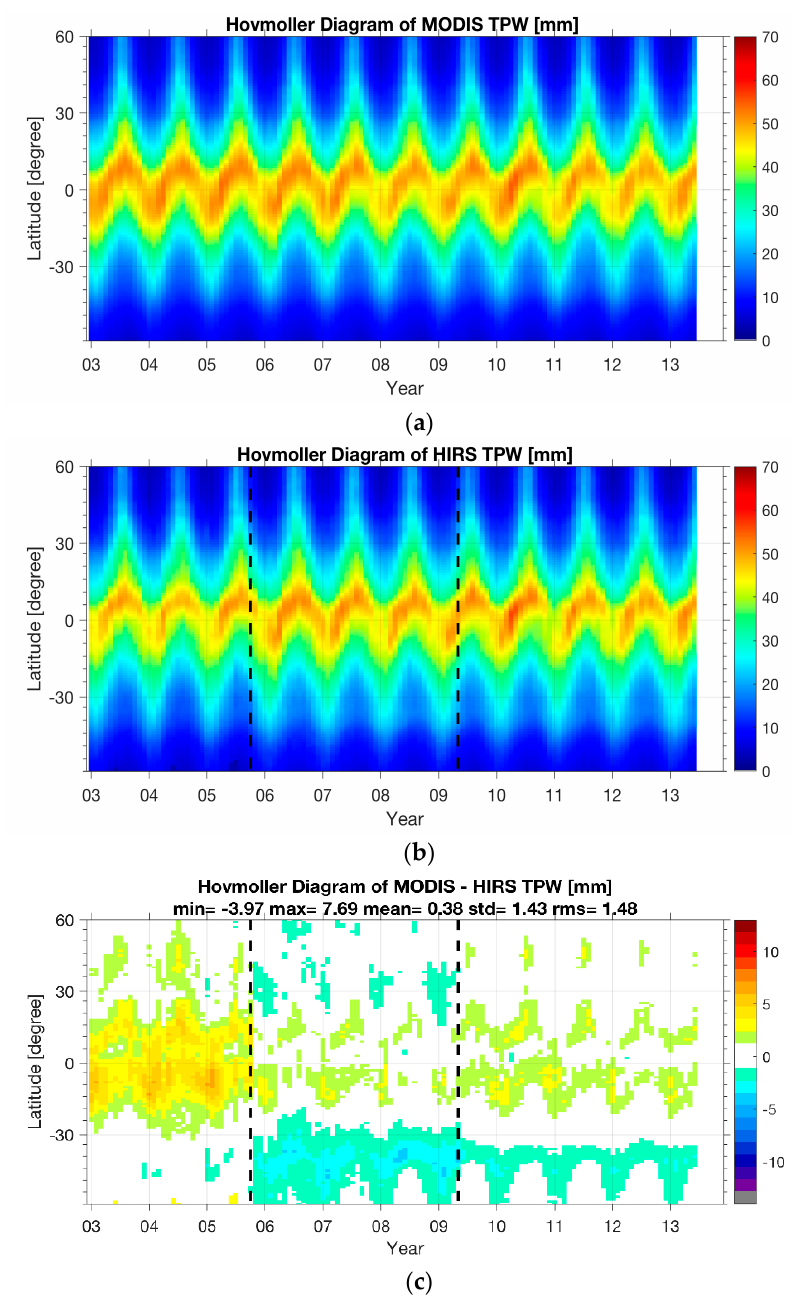
Figure 1. Hovmoller plot of clear sky Total Precipitable Water (TPW) in mm from 2003 to 2014 for Aqua Moderate Resolution Imaging Spectroradiometer (MODIS) ( a ) and National Oceanic and Atmospheric Administration (NOAA)-16, -18, and -19 High-resolution Infrared Radiation Sounder (HIRS) ( b ) along with the MODIS minus HIRS difference ( c ). Vertical dashed lines indicate the time when the operational satellite changed from NOAA-16 to NOAA-18 in November 2005 and from NOAA-18 to NOAA-19 in June 2009.